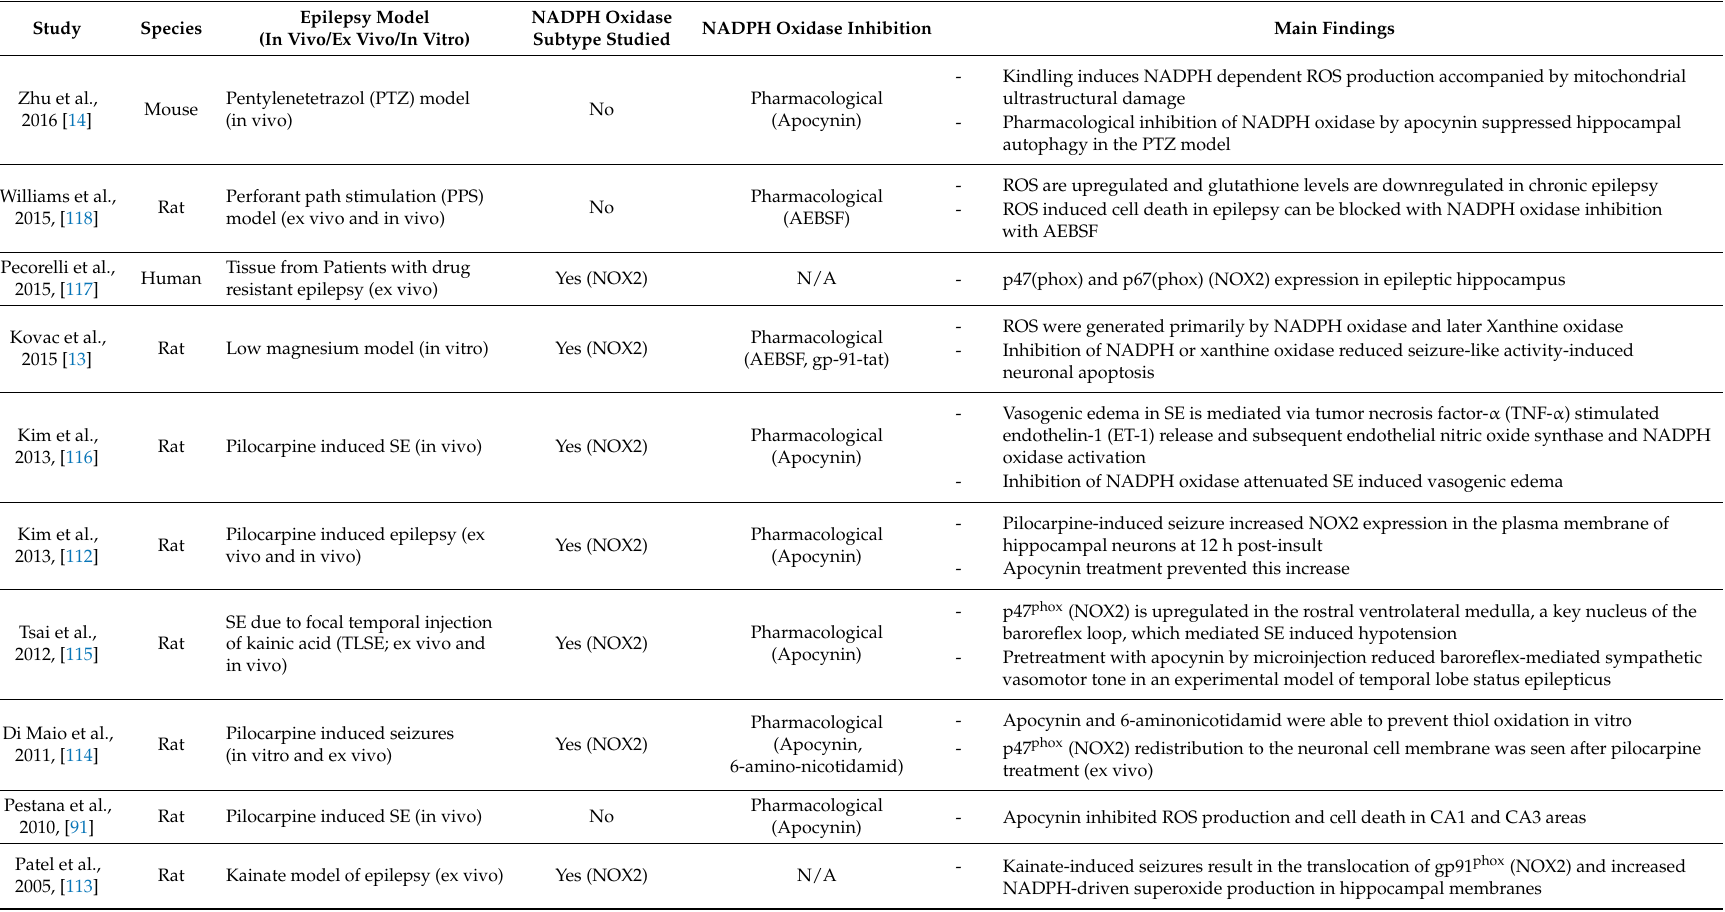
Table 1. Studies on the role of nicotinamide adenine dinucleotide phosphate (NADPH) oxidase in seizures and